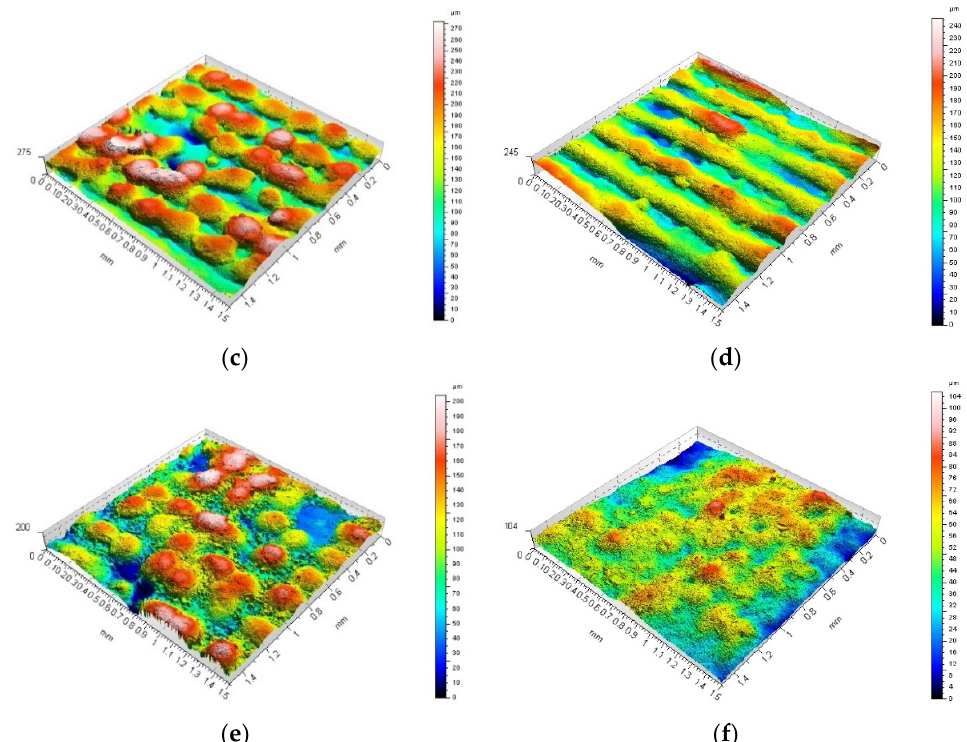
Figure 8. Examples of selected isometric views of samples taken at specific angles ( a ) sample 2—angle 0°, ( b ) sample 4—angle 0°, ( c ) sample 2—angle 45°, ( d ) sample 6—angle 45°, ( e ) sample 2—angle 90°, ( f ) sample 7—angle 90°; scales should be analysed carefully.